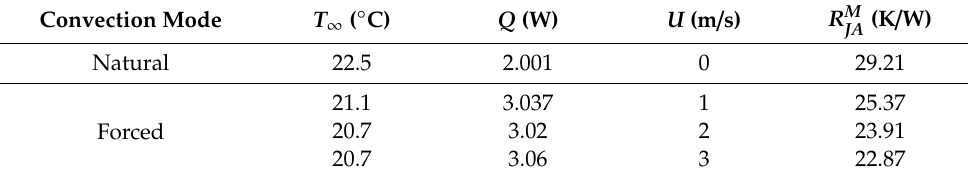
Table 2. Experimental R JA measurement of BGA208 mounted on the 2s2p